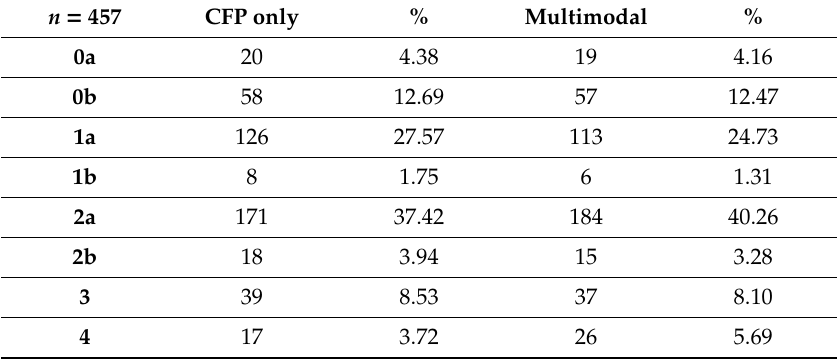
Table 2. Frequency distribution of the mutually exclusive stages of AMD by grading methodology, according to the Rotterdam